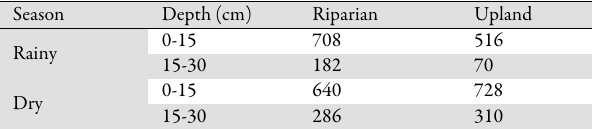
Table 5. Summary of mean density of seeds/m 2 at different depths in both seasons in the two vegetation types